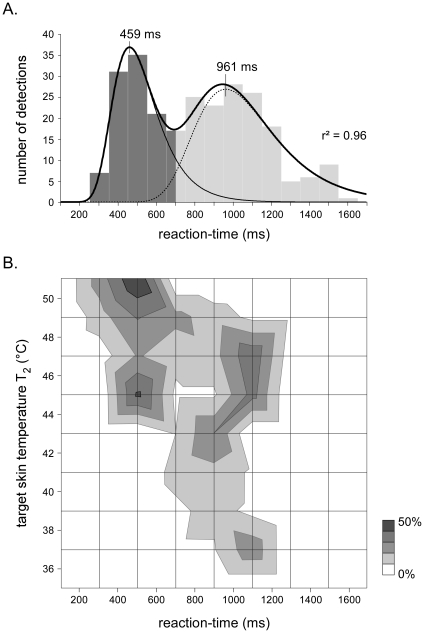
Frequency distribution of the reaction-times to brief CO2 laser pulses applied onto the dorsum of the non-dominant hand using target skin temperatures ranging from 35 to 51°C.The upper panel shows the overall distribution of reaction-times regardless of the target skin temperature (T2). The lower panel shows the distribution of reaction-times as a function of T2. Note the bimodal distribution of reaction-times, related to the fact that lower target skin temperatures triggered late-latency detections compatible with the conduction velocity of unmyelinated C-fibres, whereas higher target skin temperatures triggered early-latency detections compatible with the conduction velocity of myelinated Aδ-fibres (at higher skin temperatures, the stimulus activated both Aδ- and C-fiber afferents, but detections were related to the first-arriving Aδ-fiber afferent volley). The bimodal nature of this distribution was confirmed by comparing the fitting of the data to a model describing a unimodal vs. a bimodal distribution of sensory-motor responses (see Results). The first function of the bimodal model characterized the distribution of the short-latency Aδ-fibre responses (a = 459 ms; b = 111 ms). The second function characterized the distribution of the late-latency C-fibre responses (a = 961 ms; b = 202 ms).